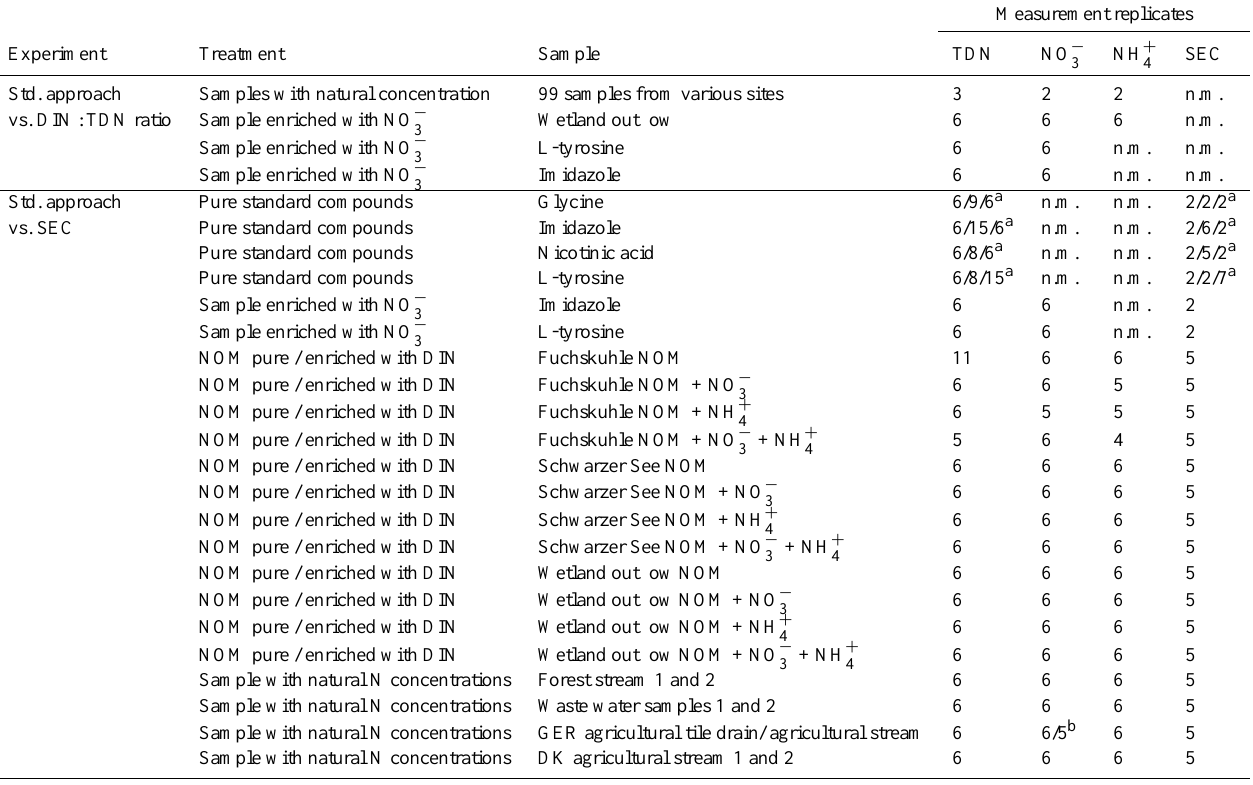
Table 1. Treatments, samples and number of measurement replicates used in the study. NOM = natural organic matter.